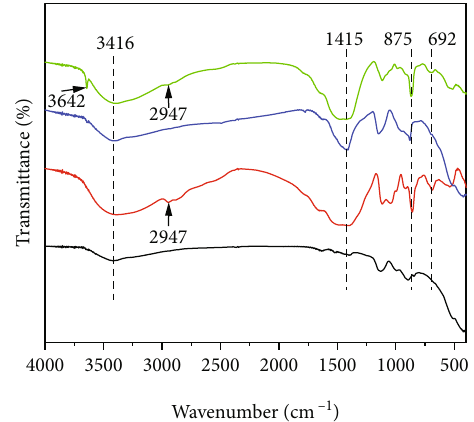
Figure 13: FTIR spectra of (a) the CS-800, (b) the reused CS-800, (c) the 15 wt.% Na CO -CS-800, and (d) the reused 15wt.% 2 3 CO Na 2 3